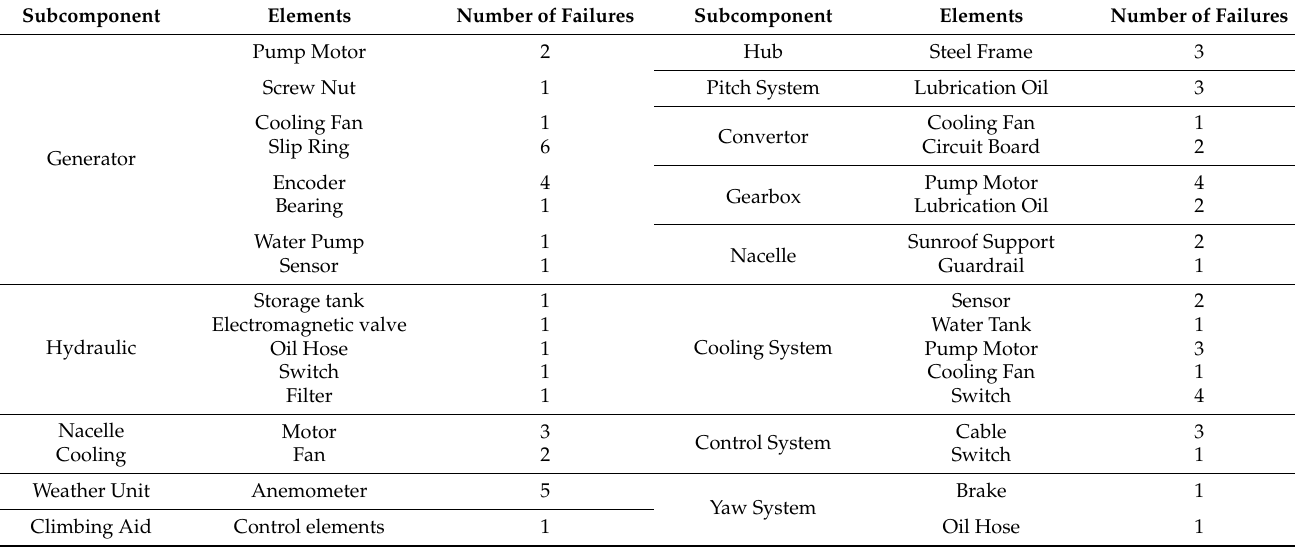
Table 8. Delayed maintenance to failures.